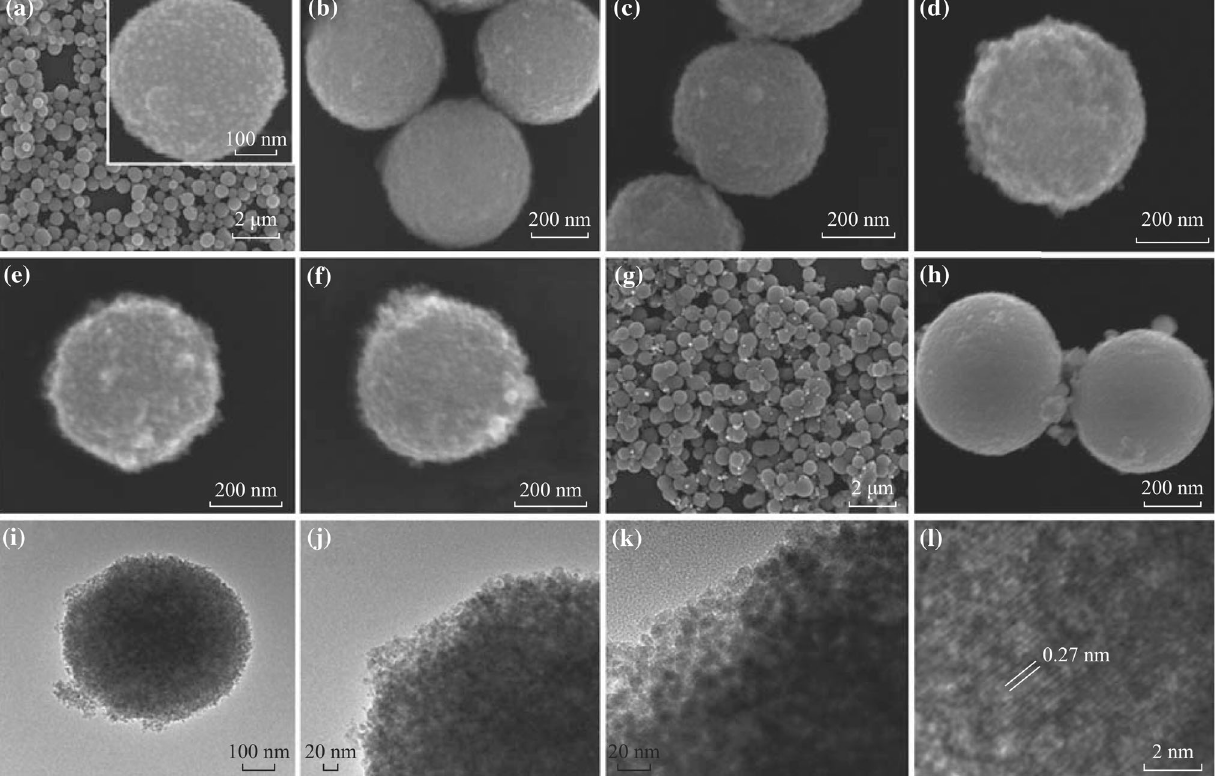
Fig. 2 FE-SEM images of Ag–AgCl@TiO 2 NPAS: a S1, b S2, c S3, d S4, e S5, f S6, g – h S7 and i – l TEM and HRTEM images of sample